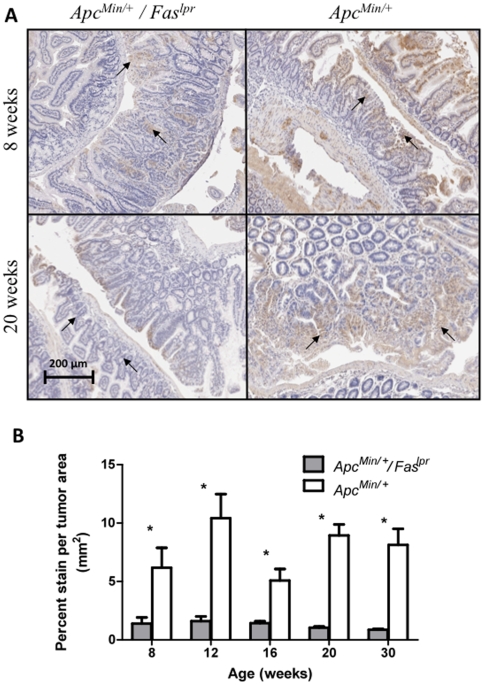
Immunohistochemistry for Fas-L in adenomas from ApcMin/
+ and ApcMin/
+
/Faslpr mice.(A) Immunostains for Fas-L comparing ApcMin/+/Faslpr and ApcMin/+ mice at 8 and 20 weeks. (B) Quantitation of Fas-L immunostains. Error bars represent standard error of the mean.